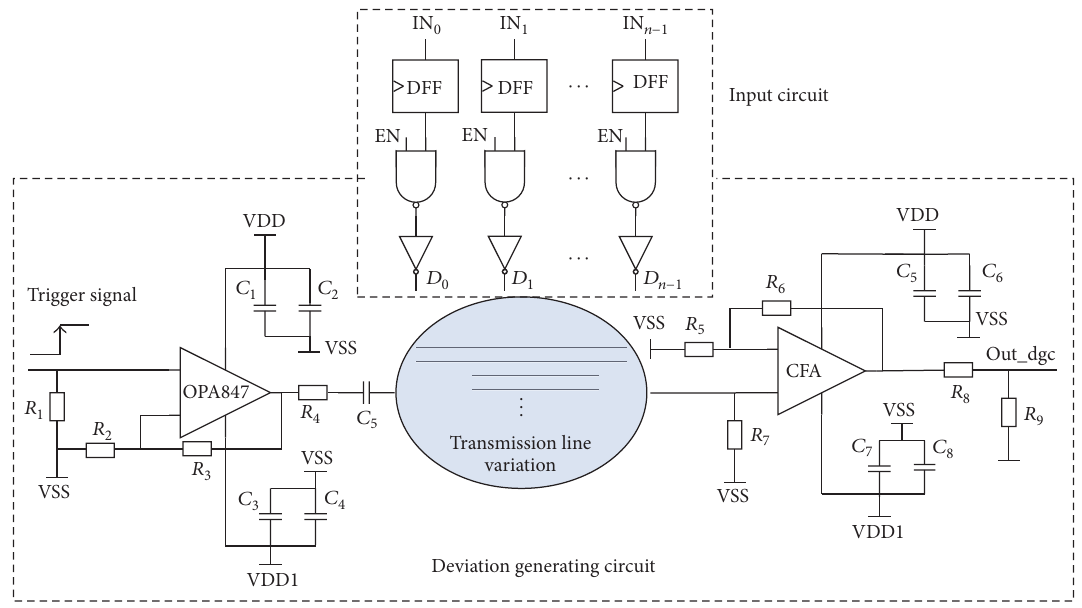
Figure 5: Input circuit and deviation generating circuit.